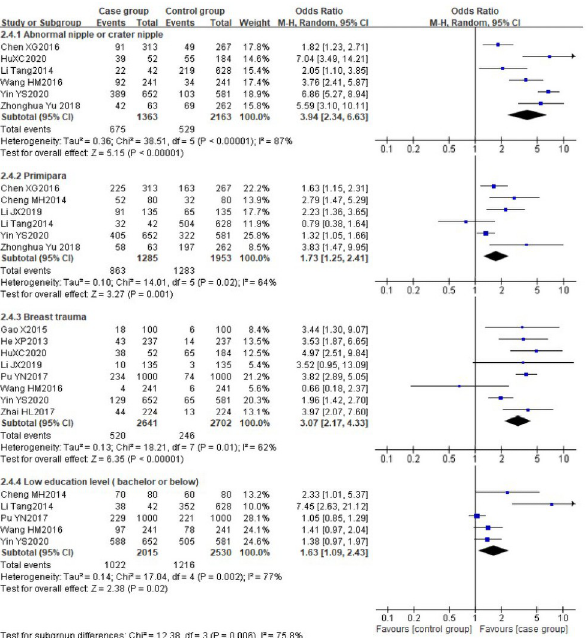
Fig 5. Forest plot comparing the pooled risks of abnormal nipple or crater nipple, primipara, breast trauma and low education level. There was obvious heterogeneity among the following risk factors ( I 2 > 50%): abnormal nip- ple or crater nipple (P < 0.00001, I 2 = 87%), primipara (P = 0.02, I 2 = 64%), breast trauma (P = 0.01, I 2 = 62%) and low education level (P = 0.002, I 2 = 77%), the data of these factors were pooled using the random effect model. The pooled risks showed that abnormal nipple or crater nipple [28, 32, 36–39] (OR 3.94, 95%CI [2.34, 6.63]), primipara [28, 31, 33, 36, 37, 39] (OR 1.73, 95%CI [1.25, 2.41]), breast trauma [29–32, 34, 35, 37, 38] (OR 3.07, 95%CI [2.17, 4.33]) and low education level (bachelor below) [30, 32, 33, 37, 39] (OR 1.63, 95%CI [1.09, 2.43]) were identified as the significant risk factors for LM. The forest plots are shown in Fig 5. Similarly, the result from one cross-sectional study [40] involving 864 participants reported that primipara (OR 3.46, 95%CI [1.04, 11.46]) and a mother with low education level (high school or below) (OR 2.2, 95%CI [1.11, 4.35]) experienced a higher risk of LM. 3.3.3 Risk factors related to postpartum period. As for the relationship between rest time of postpartum women and LM, there was no significant heterogeneity ( I 2 � 50%, P = 0.81, I 2 = 0%), the result of two studies [30, 33] showed that postpartum rest time less than 3 months was identified as a risk factor for LM (OR 4.71, 95%CI [3.92, 5.65]). The forest plot is shown in Fig 6. There was obvious heterogeneity among the following risk factors ( I 2 > 50%): the first six months postpartum (P < 0.00001, I 2 = 93%), postpartum prone sleeping position (P < 0.0006, I 2 = 80%) and postpartum mood disorders (P < 0.00001, I 2 = 83%), the data of these factors were pooled using the random effect model. The results showed that the first six months post- partum [29, 30, 32, 34, 35] (OR 5.11, 95%CI [2.66, 9.82]), postpartum prone sleeping position [29–31, 35, 37] (OR 2.46, 95%CI [1.58, 3.84]) and postpartum mood disorders [29–31, 33–35, 37–39] (OR 1.47, 95%CI [1.06, 2.02]) were identified as the significant risk factors for LM. The forest plots are shown in Fig 7. Similarly, the result from one cross-sectional study [41]